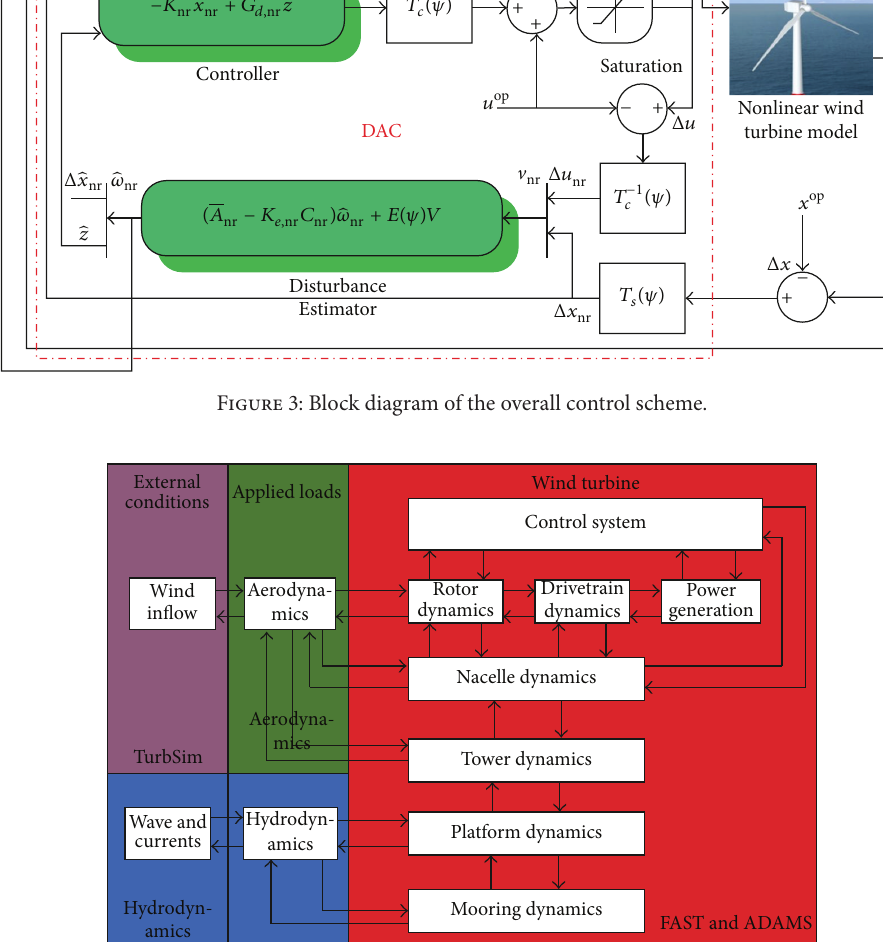
Figure 4: Offshore FAST structure (from